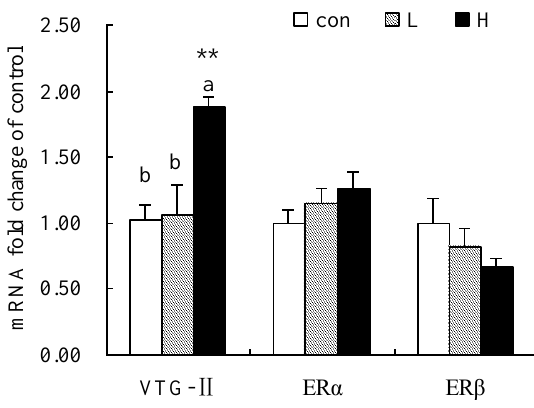
Figure 4. Effects of Kp-10 on the hepatic expression of VTG-II, ER  and ER  mRNA in quails. Values are means  SE of fifteen replications. The data points without same superscripts (a, b) are significantly different (one-way ANOVA) at the level of p<0.05 and ** at the level of p<0.01 (compared with control) by least square difference